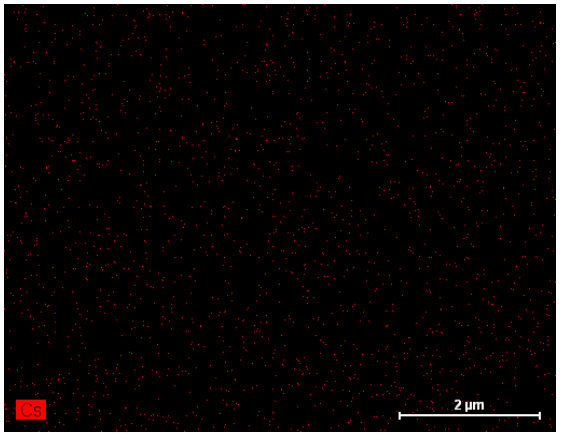
Figure 2. EDX analysis of CsPOMo/QDPSU/PTFE/H ( b ) S; ( c ) F; ( d ) P; ( e )